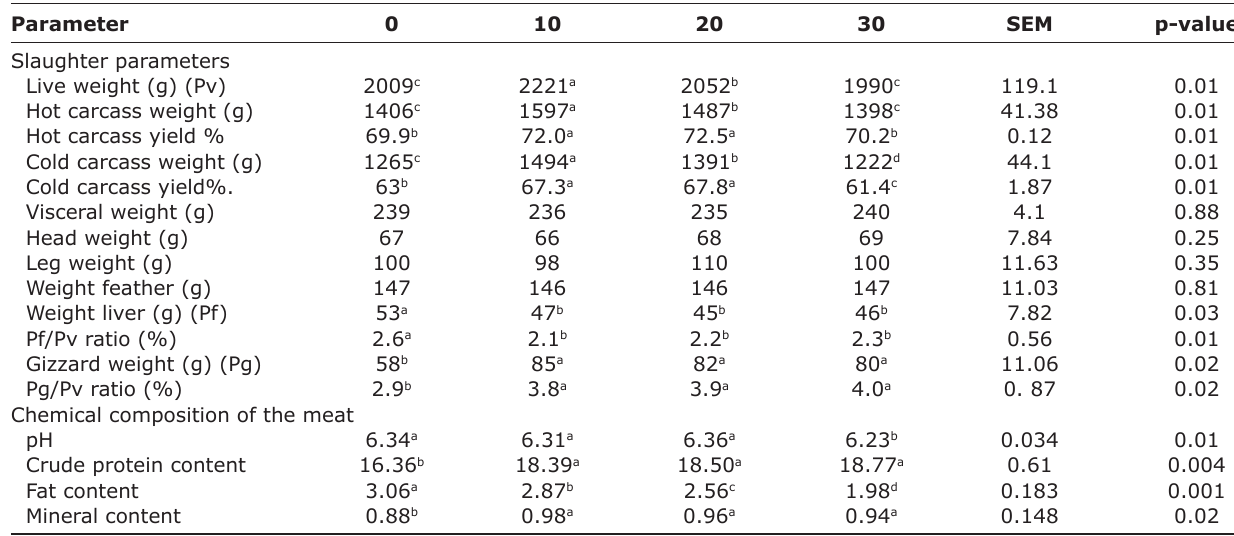
Table-5: Changes in slaughter parameters and meat chemistry as a function of the substitution rate. Parameter 0 Slaughter